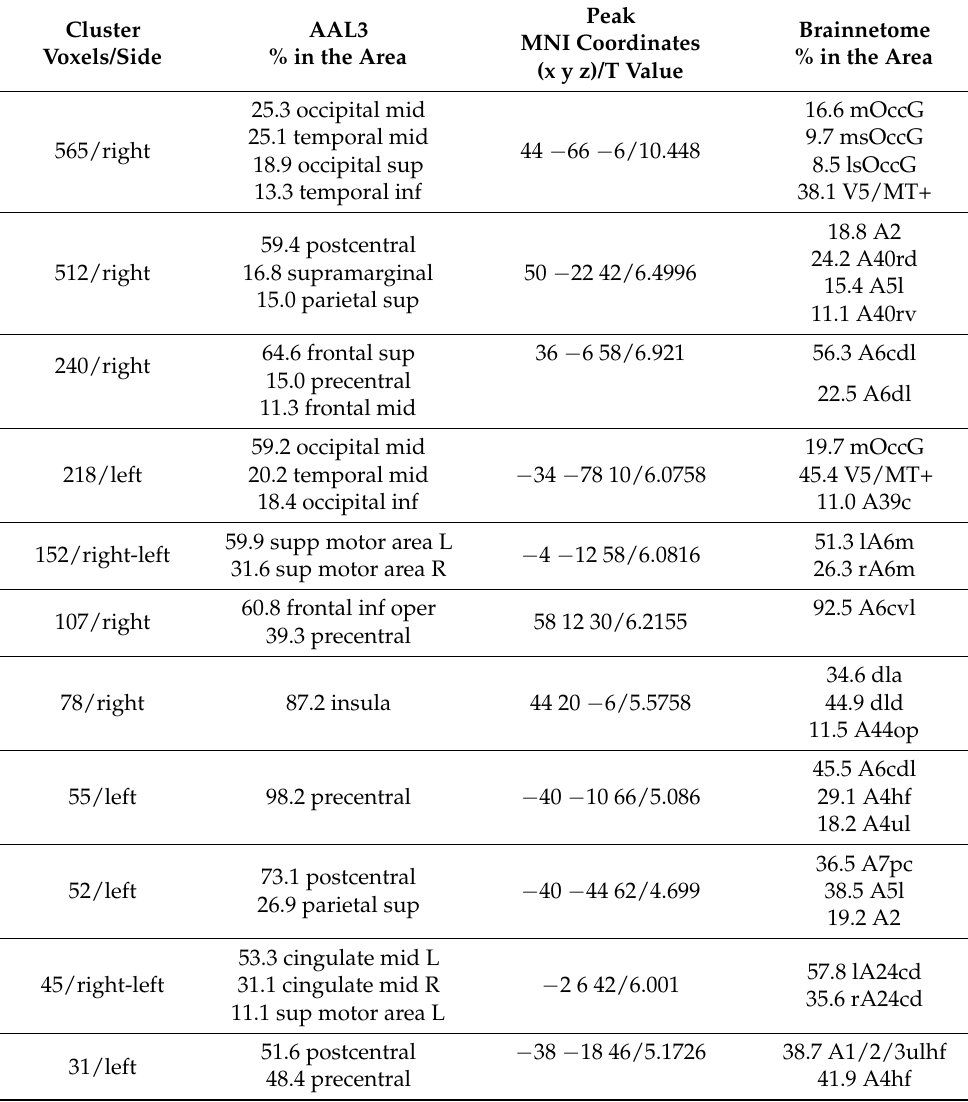
Table 2. Activated areas highlighted by “SLB > control condition” contrast. The number of voxels is given for each cluster, together with the side (i.e., left or right hemisphere), the cluster composition (i.e., the percentage of voxels in each area assigned using AAL3 and brainnetome atlas), MNI coordinates and t value of the peak. Only activated areas covering more than 10% of the cluster are shown. Peak Cluster AAL3 MNI Coordinates Voxels/Side % in the Area (x y z)/T